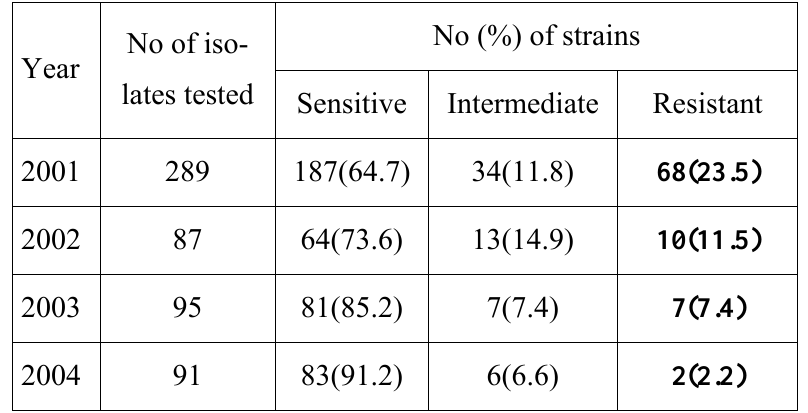
Table 12. The vancomycin susceptibility rates of enterococci isolated from broiler chickens determined by the disc diffusion